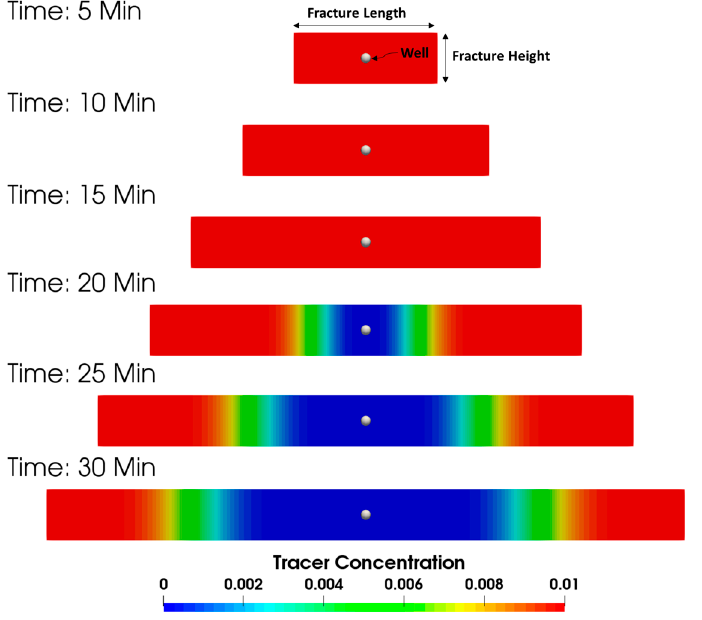
Figure 4. Slug injection in a propagating planar fracture. Fracture surface plane is shown at di ff erent times during fracture propagation.